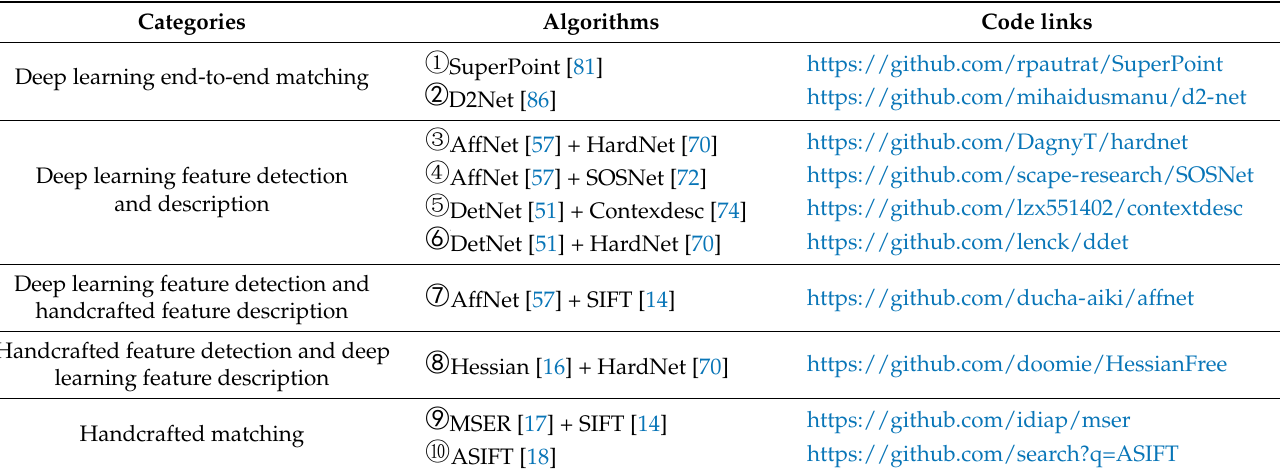
Table 1. Representative algorithms and their references.